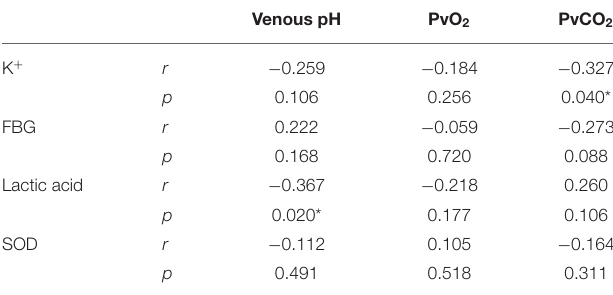
TABLE 6 | Correlation analysis of venous pH, PvO 2 , PvCO 2 , and other effect indicators in the SCH group. Venous pH PvO 2 PvCO 2